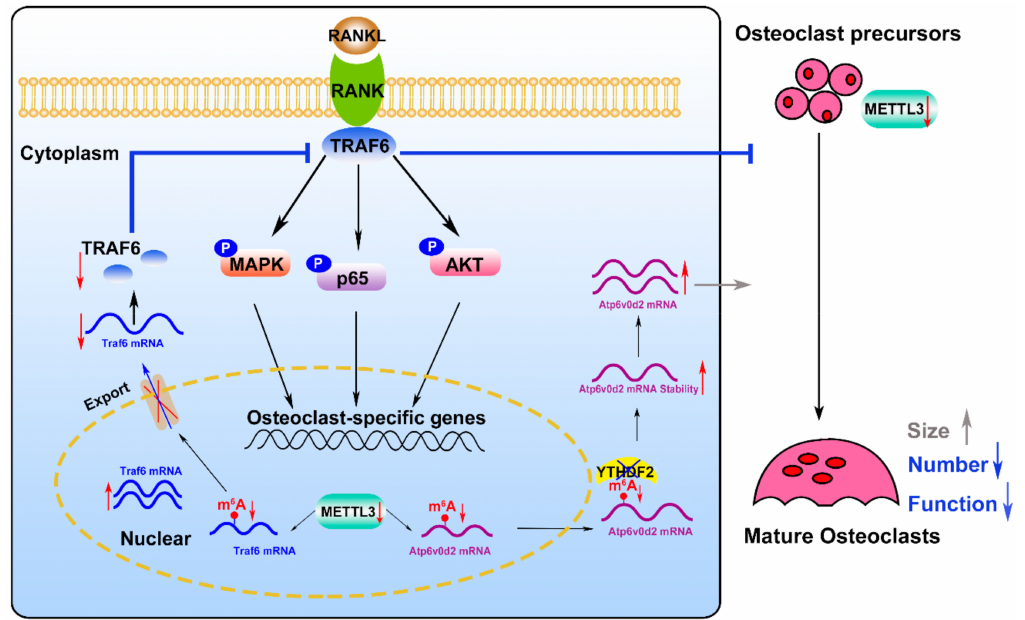
Figure 7. A working model depicting the role and the mechanisms of METTL3-dependent m 6 A modification in osteoclast di ff erentiation. Mettl3 knockdown causes the retention of Traf6 mRNA in the nucleus, which might result in the inactivation of RANKL-induced signaling pathways and suppress osteoclast-specific gene expression, as well as inhibit osteoclast formation and function. In addition, Mettl3 knockdown upregulates Atp6v0d2 mRNA expression and stability via YTHDF2 involvement, leading to the formation of large, multinucleated